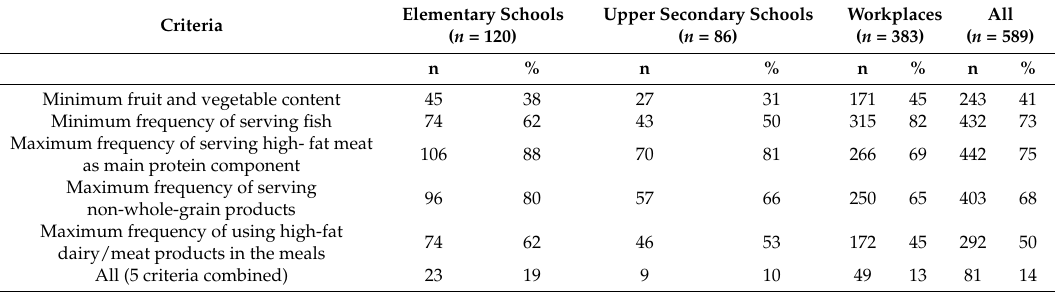
Table 3. Compliance with the guidelines for hot